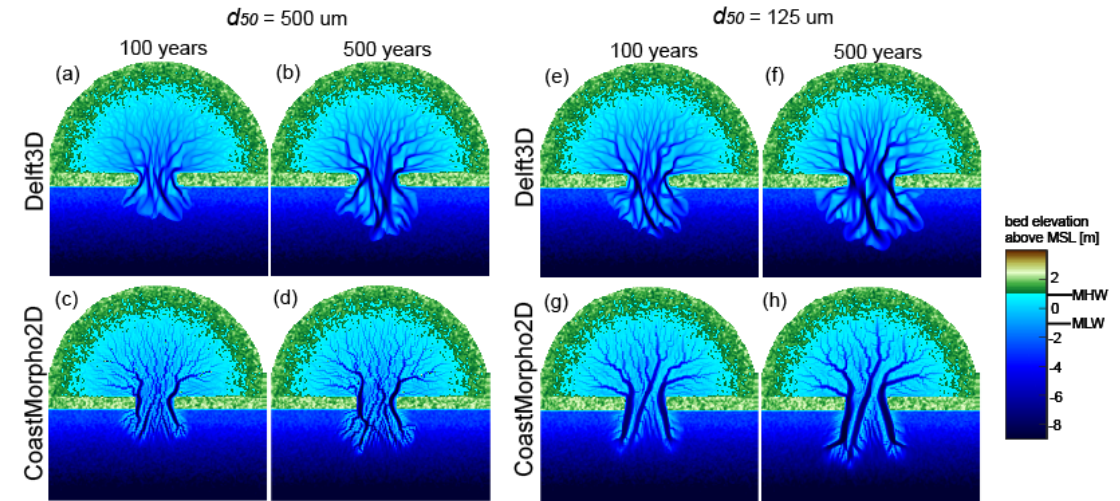
Figure 10. Comparison between Delft3D and CM2D for different sediment grain size. Simulations are compared at year 500 with the reference parameters (Figure 5e). ( a – d ) Median grain size equal to 500 μm; ( e – h ) Median grain size equal to 125 μm.